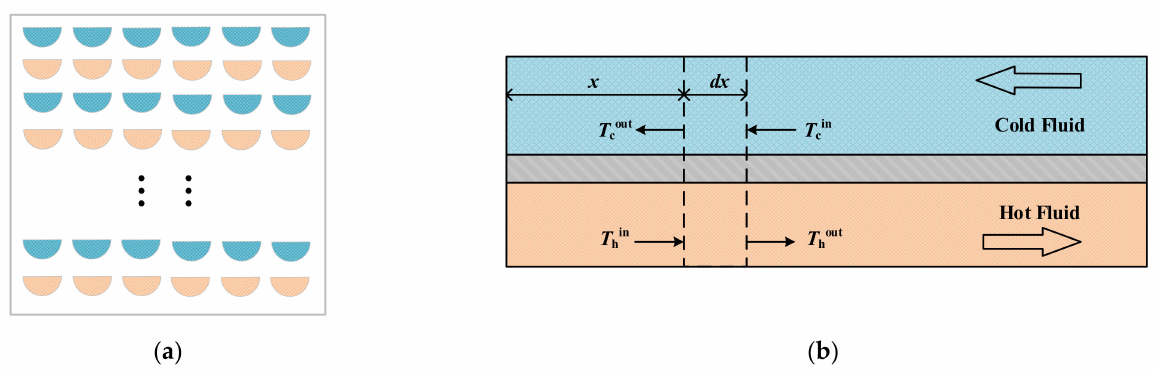
Figure 2. The model of PCHE. ( a ) the structure of PCHE. ( b ) schematic diagram of PCHE partition